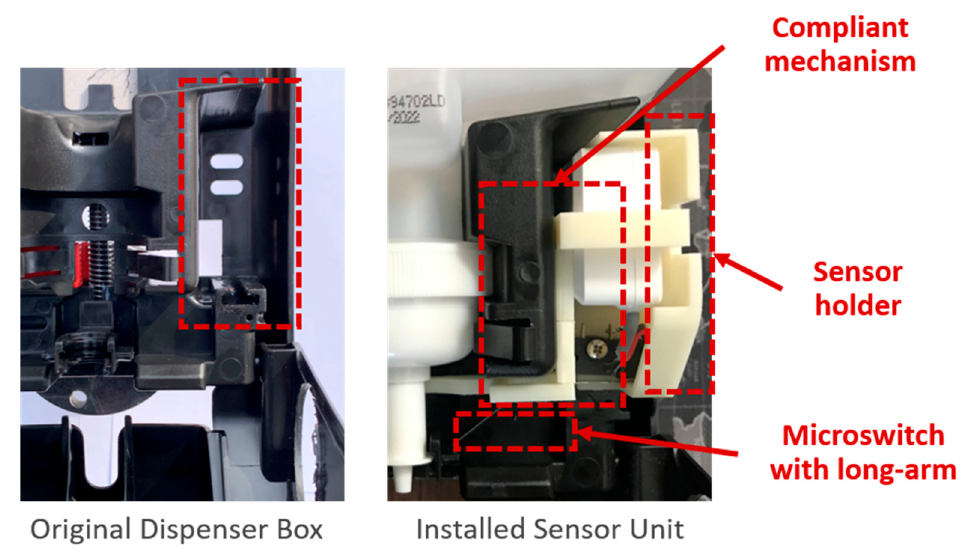
Figure 6. Sensor holder design for “plug-and-play” deployment in existing dispensers.